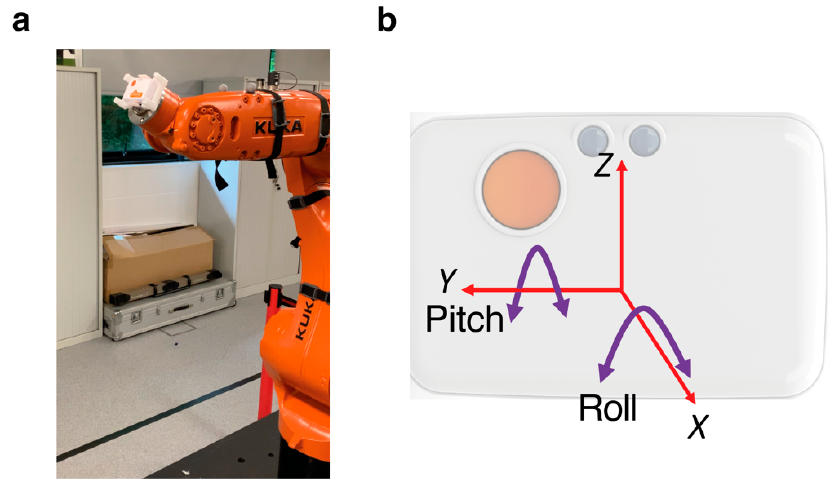
Figure A1. ( a ) Photograph of the equipment set up, with the IMU mounted onto the end-effector of the robot arm. ( b ) Axes of the IMU. Only the pitch was of interest in this study. However, roll was applied to some measurements to check for interactions with the pitch measurements.